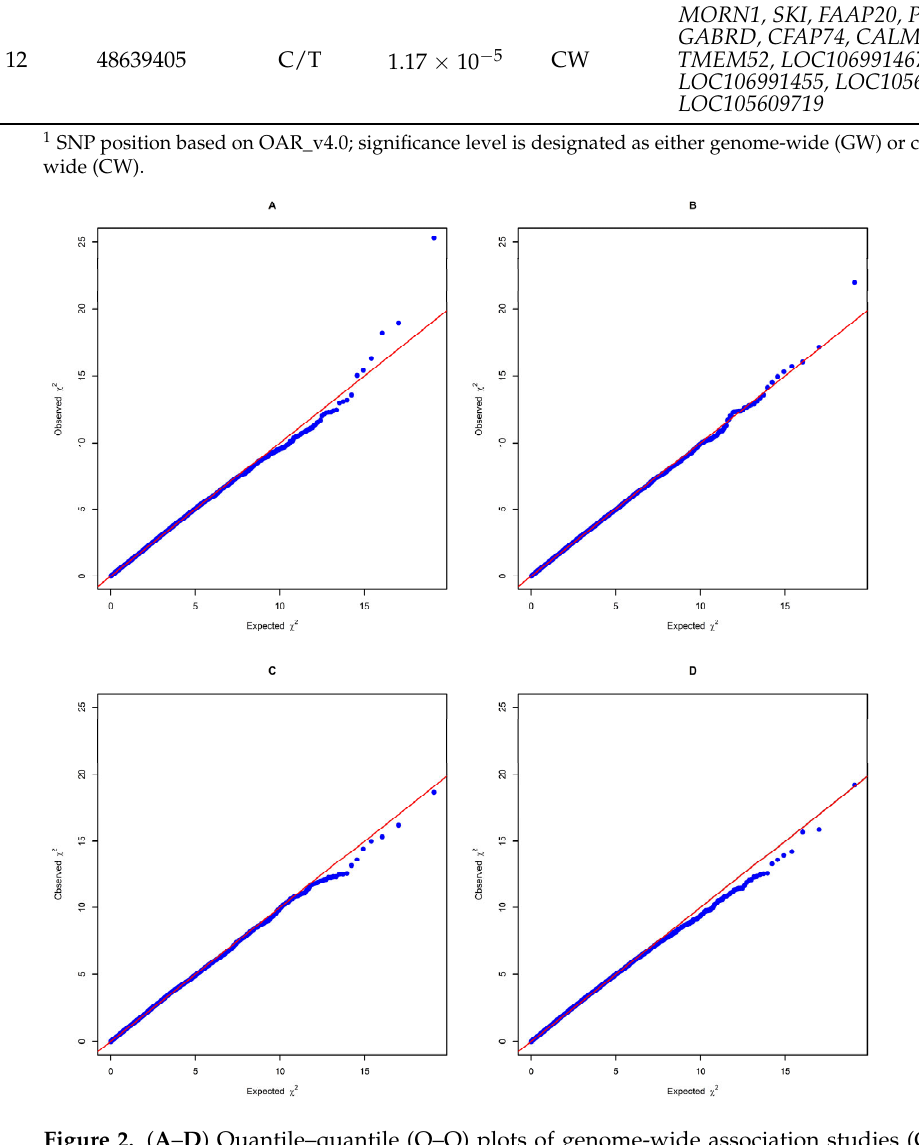
Figure 2. Quantile–quantile (Q–Q) plots of genome ‐ wide association studies (GWAS) for wool traits. Figure 2. ( A – D ) Quantile–quantile (Q–Q) plots of genome-wide association studies (GWAS) for wool Table 3. Significant SNPs associated with wool traits.